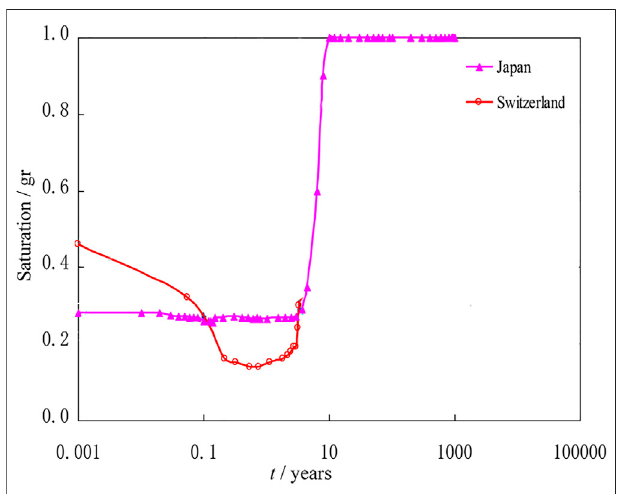
FIGURE 2 | Model of buffer material saturation for HLNW container in short- and